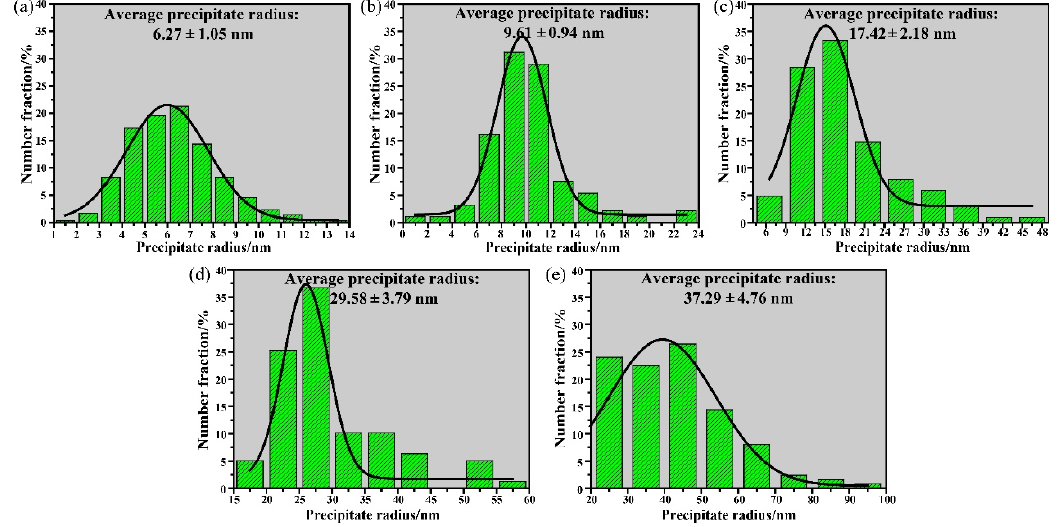
Figure 8. Precipitate radius distributions for the 7085 alloy after various heat treatments: ( a ) sample I (25 °C), ( b ) sample II (100 °C), ( c ) sample III (125 °C), ( d ) sample IV (150 °C), and ( e ) sample V (175 °C).